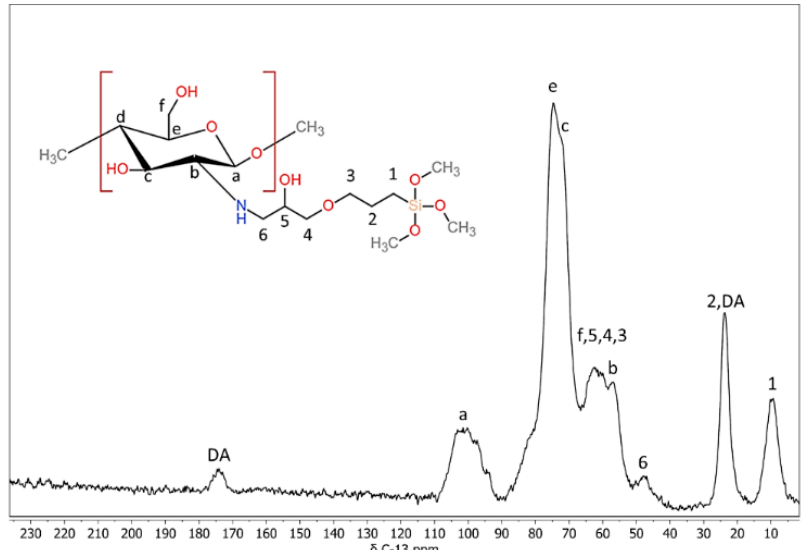
Figure 3. Characterization of covalent coupling in hybrid materials. 13 C Magic-angle spinning nuclear magnetic resonance (MAS-NMR) spectra of the hybrid material. Covalent coupling was confirmed by peak “6”, which was from a nucleophilic attack of the primary amine in chitosan on the epoxide of 3-glycidyloxypropyltrimethoxysilane (GPTMS). The absence of other peaks associated with coupling of these species indicated that the amine in chitosan was the sole site of coupling.